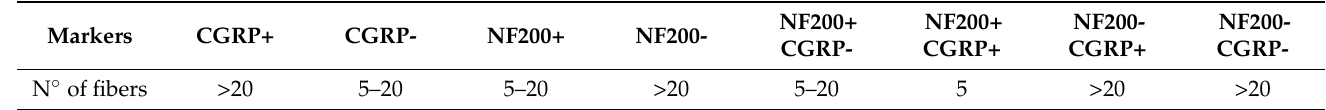
Table 3. Number of nerve fibers in periosteum in relation to immunohistochemical marker types according to Thai et al. (2020) [9].